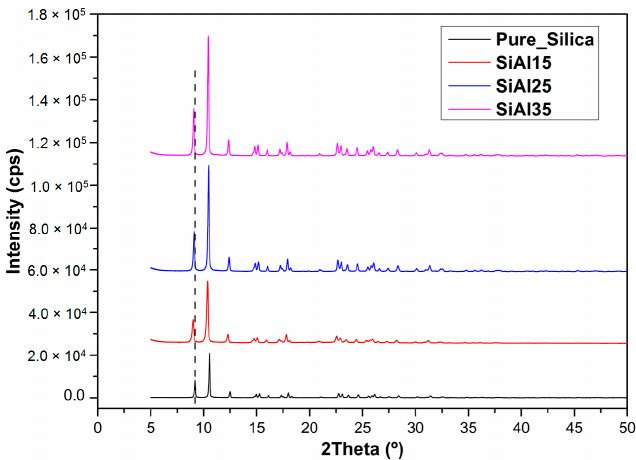
Figure 2. X-ray diffractograms of the calcined products.